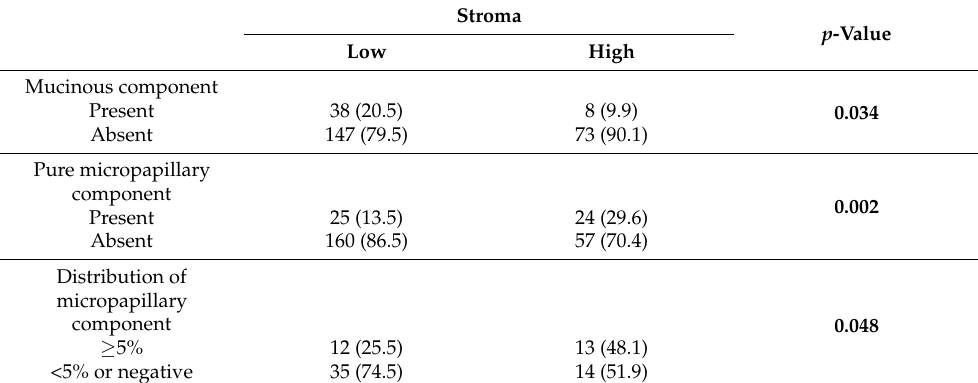
Table 2. The correlation between the tumor–stroma ratio and tumor subtypes in colorectal cancers.